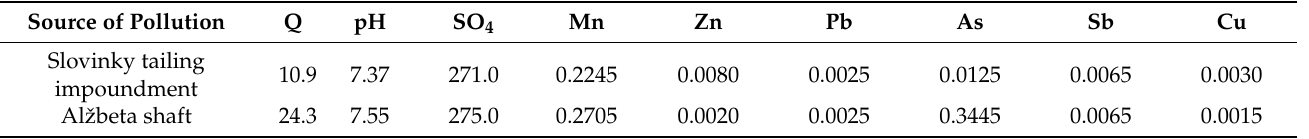
Table 1. Amount of drainage water (L/s) and content of risk elements (mg/L) of drainage water of the Slovinky tailing impoundment and mining waters of the Alžbeta shaft in 2015